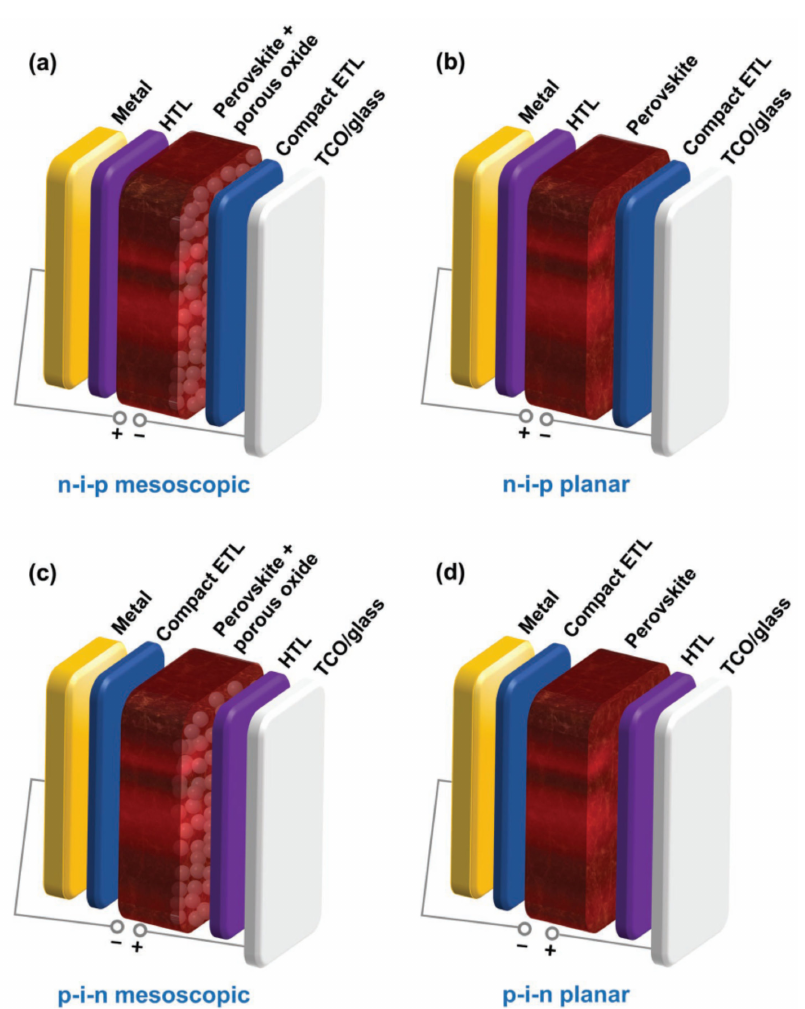
Figure 2. Four typical PSC architectures. Reprinted with permission from Ref. [58]. Copyright 2019 WILEY-VCH Verlag GmbH & Co. KGaA,